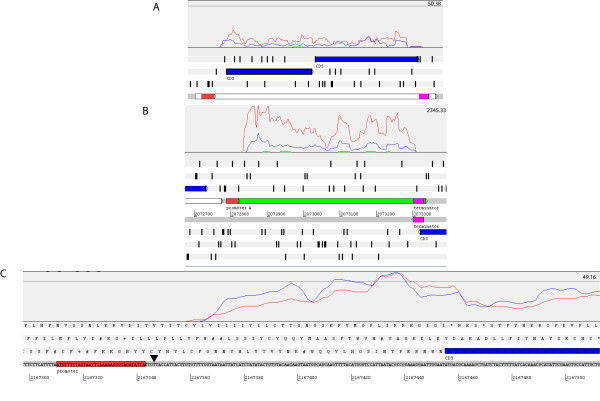
Examples of σB-dependent transcripts identified by RNA-Seq. In each panel (A, B, and C), red and blue lines representing normalized RNA-Seq coverage (i.e. the number of reads that match an annotated gene after normalization across runs) in the two 10403S replicates and green and black lines represent normalized RNA-Seq coverage in the ΔsigB strain replicates; the numbers at the top right in each panel indicates the normalized RNA-Seq coverage represented by the horizontal line shown. Panel (A) depicts LMRG_02382 and LMRG_02383 (shown as blue bars), which form an operon (indicated by a long white bar) with a defined Rho-independent terminator (purple bar) downstream of LMRG_02383; the three positive frames of translation with the coding regions in blue and stop codons shown as vertical black bars are also shown. A σB-dependent promoter (red bar) was identified upstream of the operon and the RNA-Seq coverage data clearly shows that the transcription of this operon is positively regulated by σB (i.e. almost no coverage was obtained from the ΔsigB strain). Panel (B) depicts SbrE (Rli47), a σB-dependent noncoding RNA (ncRNA) with Rho-independent terminator and a σB-dependent promoter identified; annotated features as well as positive and negative frames of translation are shown at the bottom with stop codons shown as vertical black bars. Panel (C) shows the 5' end of LMRG_01602 illustrating the position of a σB-dependent promoter in relation to the start codon of the gene and the transcriptional start site determined by RNA-Seq. The black triangle indicates the transcriptional start site determined by RACE-PCR as previously described by Kazmierczak et al. [23].